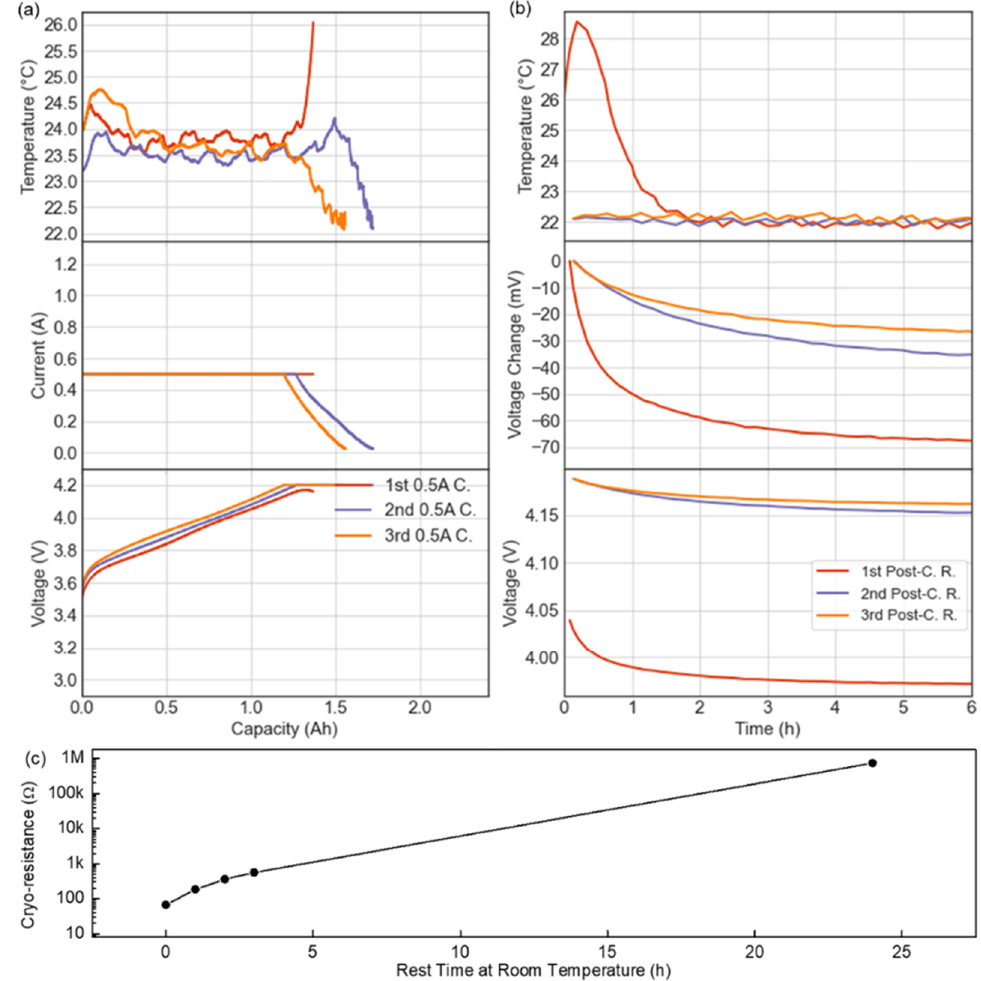
Figure 3. ( a ) Example electrical measurement results of a used cell in three 0.5 A cycles between 3.0 and 4.2 V, with charging interruption at the detection of ECTR. ( b ) Voltage and temperature evolutions during the 6 h rest period after each charge process in panel ( a ). The voltage change is relative to the voltage measured 5 min after charging ended. ( c ) Cryo-resistance of one cell when rested at room temperature for up to 24 h after the initial detection of ECTR. ( a , b ) show the date for the same cell, which ( c ) shows the data from a different cell. In the legends, “C.”, “D.”, and ‘R.’ represent charge, discharge, and rest processes, respectively.